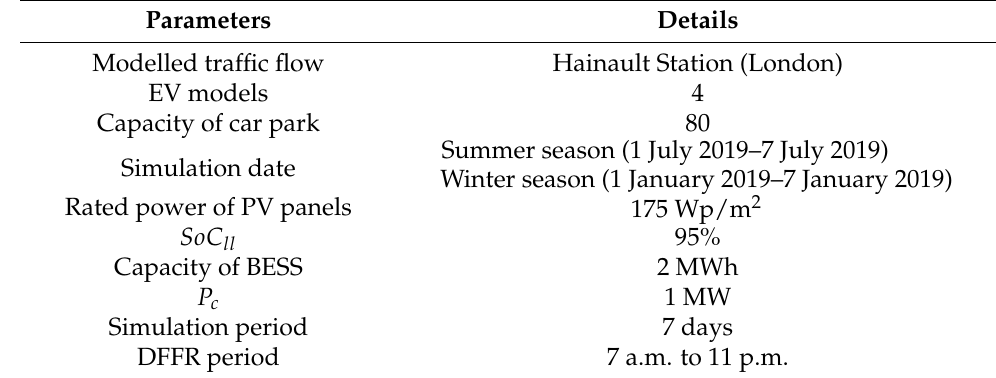
Table 4. The main parameters of the sensitivity